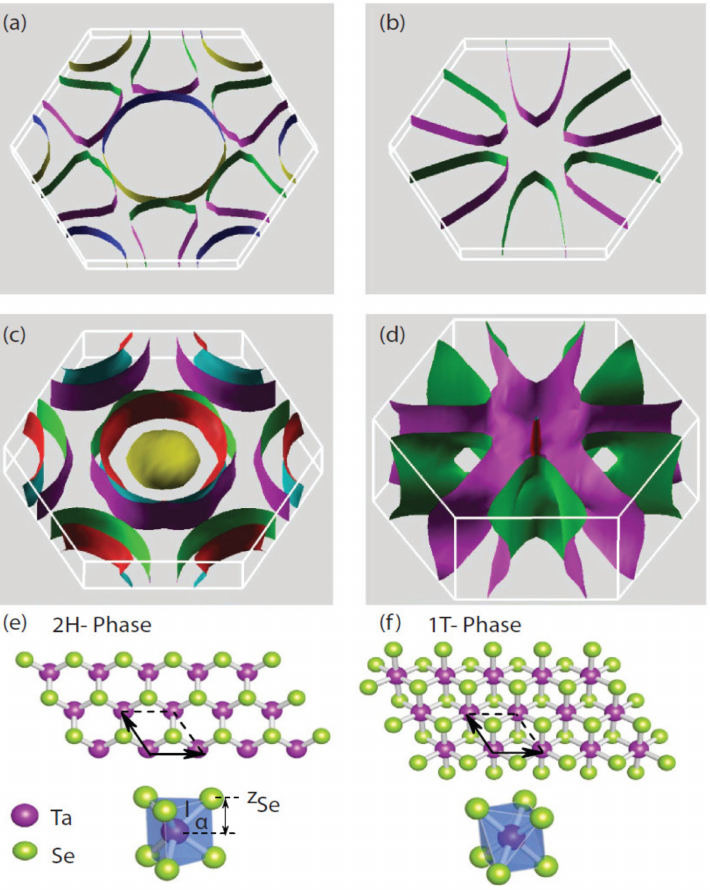
Figure 2. ( a ) Fermi surfaces are calculated for monolayer 2 H -TaSe 2 , ( b ) monolayer 1 T -TaSe 2 , and ( c , d ) their respective bulk counterparts with spin–orbit coupling (SOC) explicitly included [82].